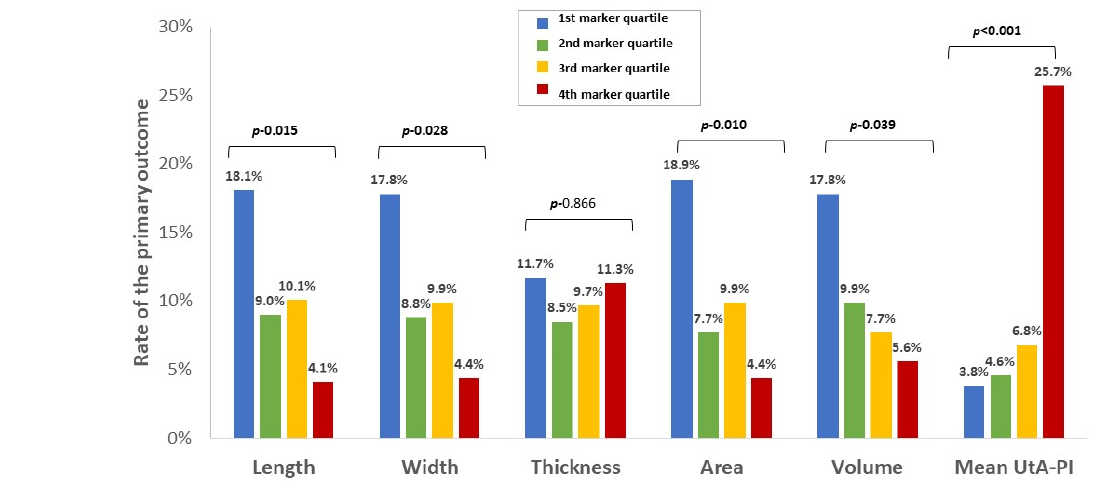
Figure 2. Relationship between the continuous placental markers and rate of the primary outcome. The rate of the primary outcome is shown for each quartile of the six continuous sonographic placental markers (expressed in MoM): placental length, width, thickness, area, and volume, and uterine artery PI. MoM, multiples of median; PI, pulsatility index; UtA, uterine